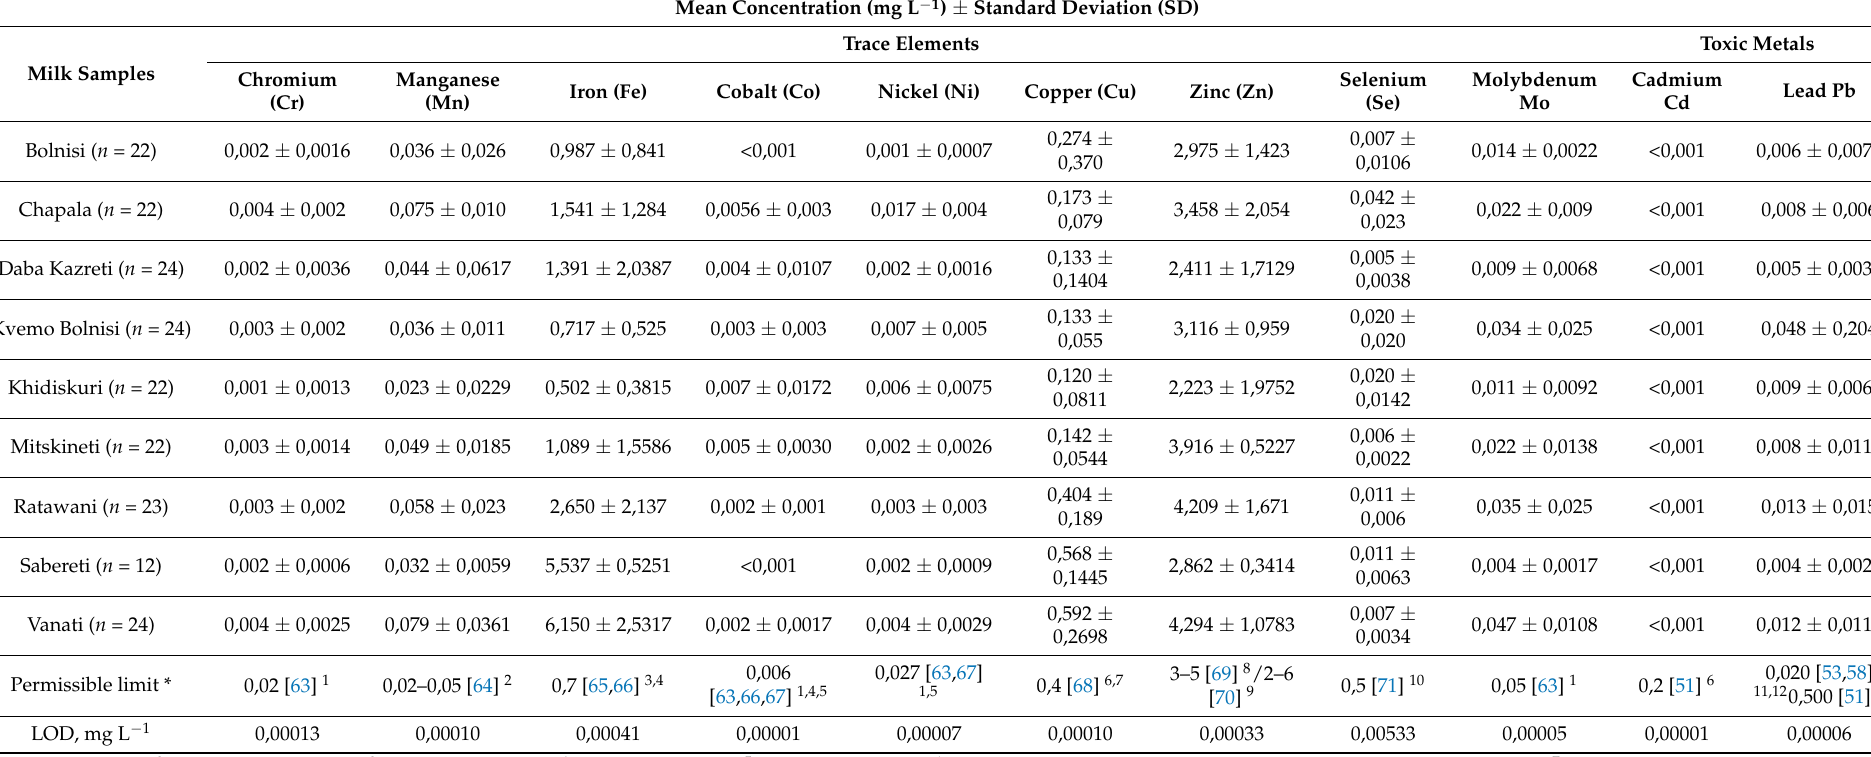
Table 1. Essential trace elements and heavy metal in milk n = 195 (mean ± standard deviation; mg L − 1 ) obtained in an area with water and pastures contaminated with heavy metal through mining industry in the Kvemo Kartli region,